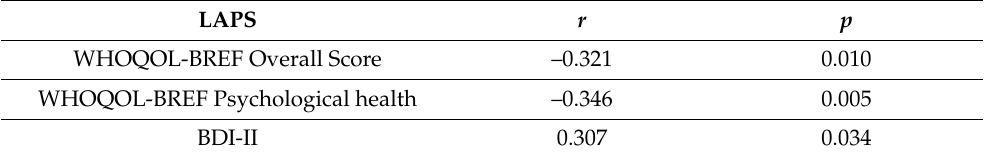
Table 9. Significant correlations regarding the strength of the human-animal relationship “Long